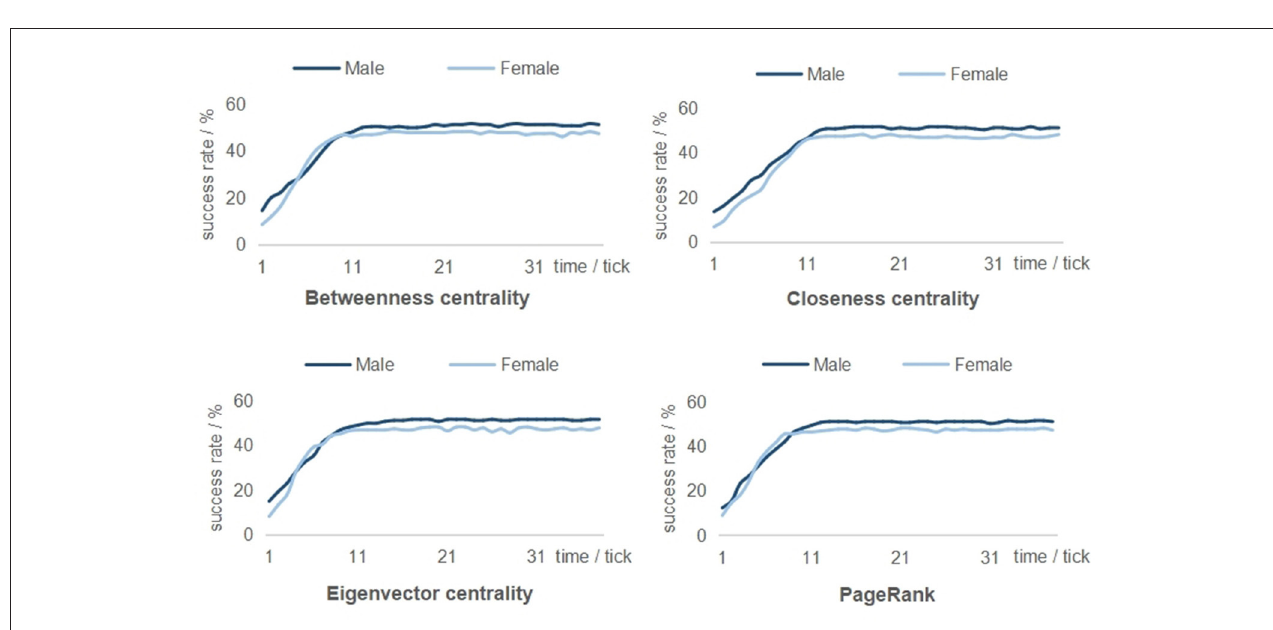
FIGURE 3 | Gender differences under four centrality-based